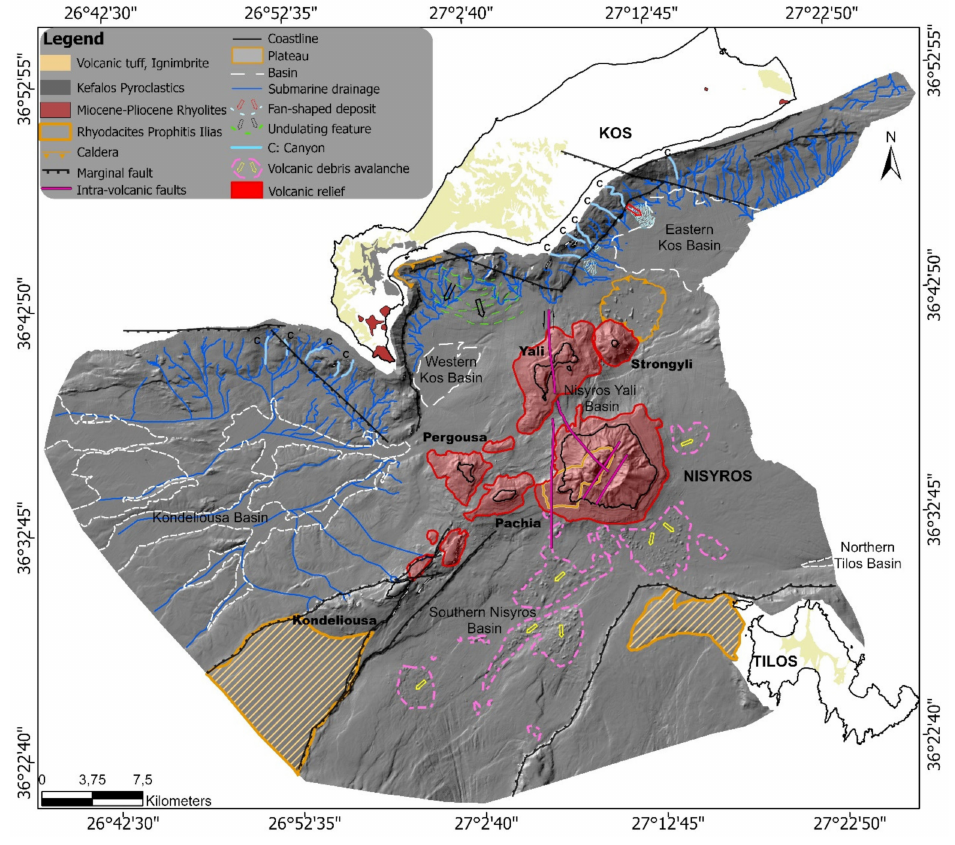
Figure 14. Integrated offshore morphotectonic map of Kos-Nisyros volcanic field. The shaded relief map comprises several volcanic and geomorphological features. The submarine volcanic relief is shown in red polygons whereas the onshore volcanic outcrops are delineated by the coastline in black. The volcanic edifice comprises also the two submarine calderas and the Nisyros volcanic debris avalanches. On Kos and Tilos islands the volcanic formations are also displayed showing the connection with offshore volcanic